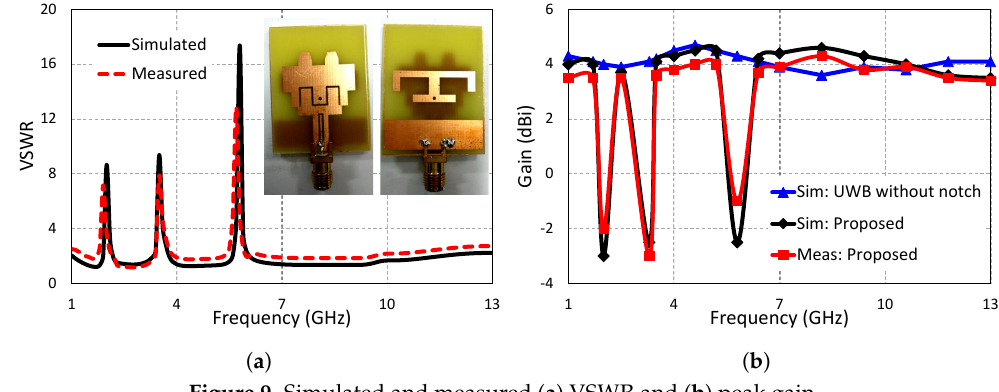
Figure 9. Simulated and measured ( a ) VSWR and ( b ) peak